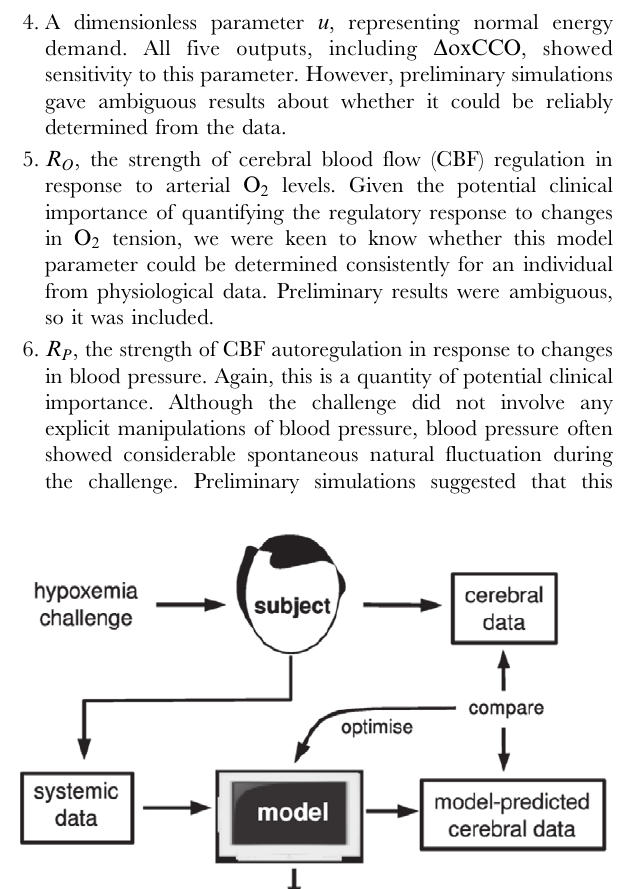
Figure 2. Examples of behaviour of the input signals. In both figures, arrows indicate the start of each hypoxemic challenge. Left. The mean arterial blood pressure trace for Subject 2 showing a marked increase during the experiment. Right. The end tidal CO 2 tension for Subject 5 was maintained relatively constant across the hypoxemic challenges.